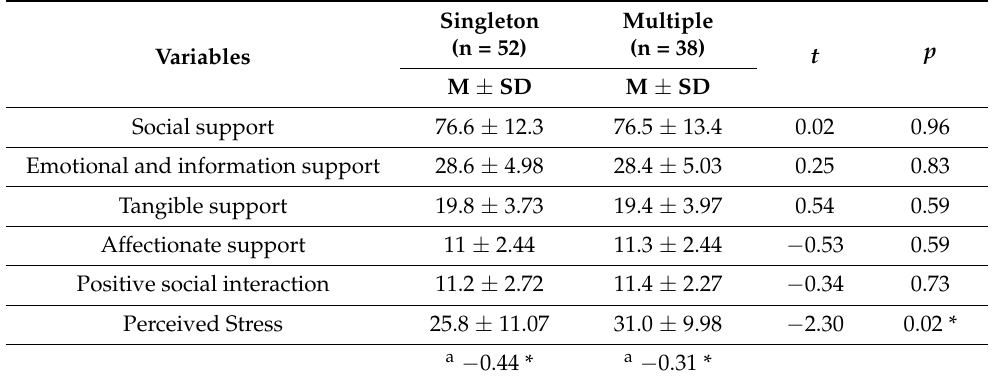
Table 2. The social support and perceived stress in mothers with singleton and multiple births at one month after